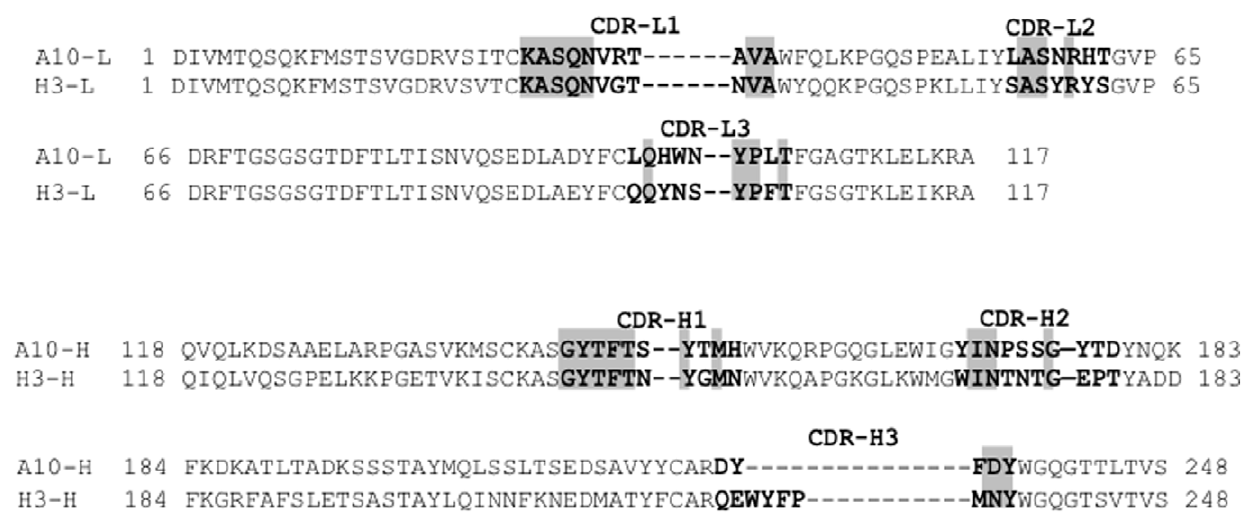
Figure 7. Amino acid sequences of anti-rNcSAG1 antibody variable regions. The amino acid numbers are according to the Kabat numbering scheme. The amino acids of CDR are bolded, and the identified amino acids in CDR are highlighted.